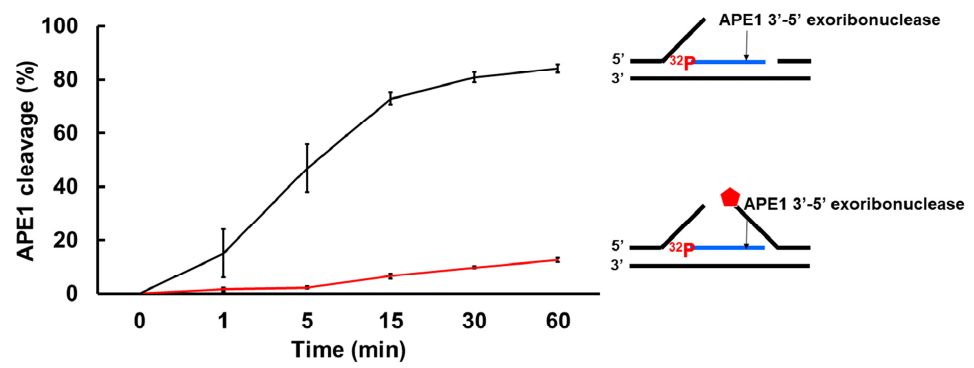
Figure 8. APE1 exonucleolytic cleavage of RNA is stimulated by the absence of the downstream 5 (cid:48) -DNA flap in an R-loop. The efficiency of APE1 exonucleolytic cleavage on the RNA strand on the R-loop intermediate with and without a 5 (cid:48) -flap was examined using the substrates labeled with 32 P at the 5 (cid:48) -end of the RNA strand of the substrates. Substrates (25 nM) were incubated with 25 nM APE1 at 37 ◦ C at different time intervals. The percentage of APE1 3 (cid:48) -exonucleolytic cleavage products were plotted against the time. APE1 exonucleolytic cleavage on the RNA strand in the R-loop substrate with 3 (cid:48) -flap alone was in black, whereas its cleavage activity on the RNA in the R-loop double-flap substrate was in red. The experiments were performed in triplicate. 3.5. FEN1 and APE1 Cleavage of RNA Coordinates to Facilitate BER in an R-Loop To further determine if FEN1 and APE1 cleavage on RNA can coordinate to promote the resolution of an R-loop through BER, we reconstituted BER on the R-loop substrates in the presence of increasing concentrations of FEN1 or APE1 (Figure 9). We found that increasing concentrations of FEN1 (1–25 nM) led to the increasing amount of repaired products with the presence of 5 nM pol β , 10 nM LIG I in the presence and absence of 50 nM APE1 (Figure 9A,B, lanes 4–7). Increasing concentrations of APE1 at 5–50 nM in the presence of a high concentration of FEN1 at 25 nM did not alter the amount of the repaired product (Figure 9C, lanes 4–7). However, since APE1 is much more abundant than FEN1 in human cells, the results suggest that the large amount of APE1 can employ its 3 ′ -5 ′ exonuclease activity to cleave RNA in R-loops through coordinating with a limited